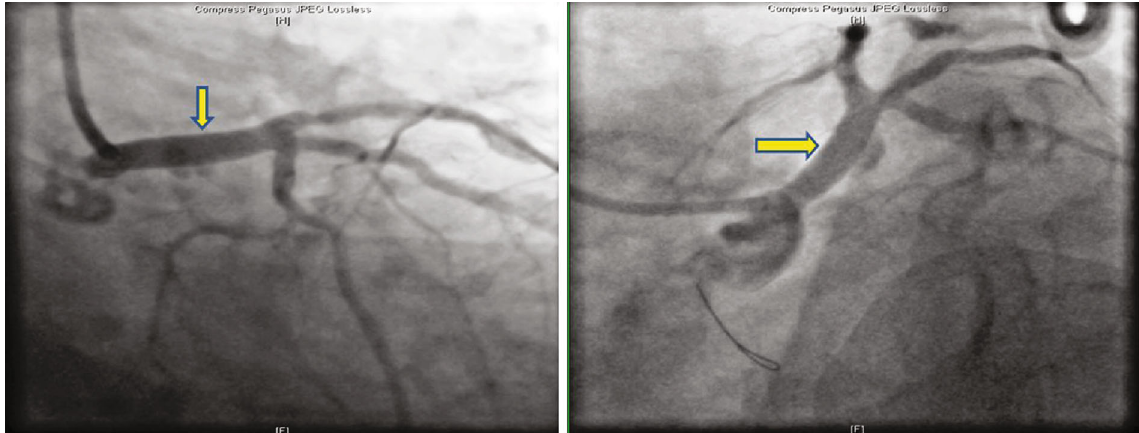
Figure 7: AP caudal and spider view showing post left main aneurysm